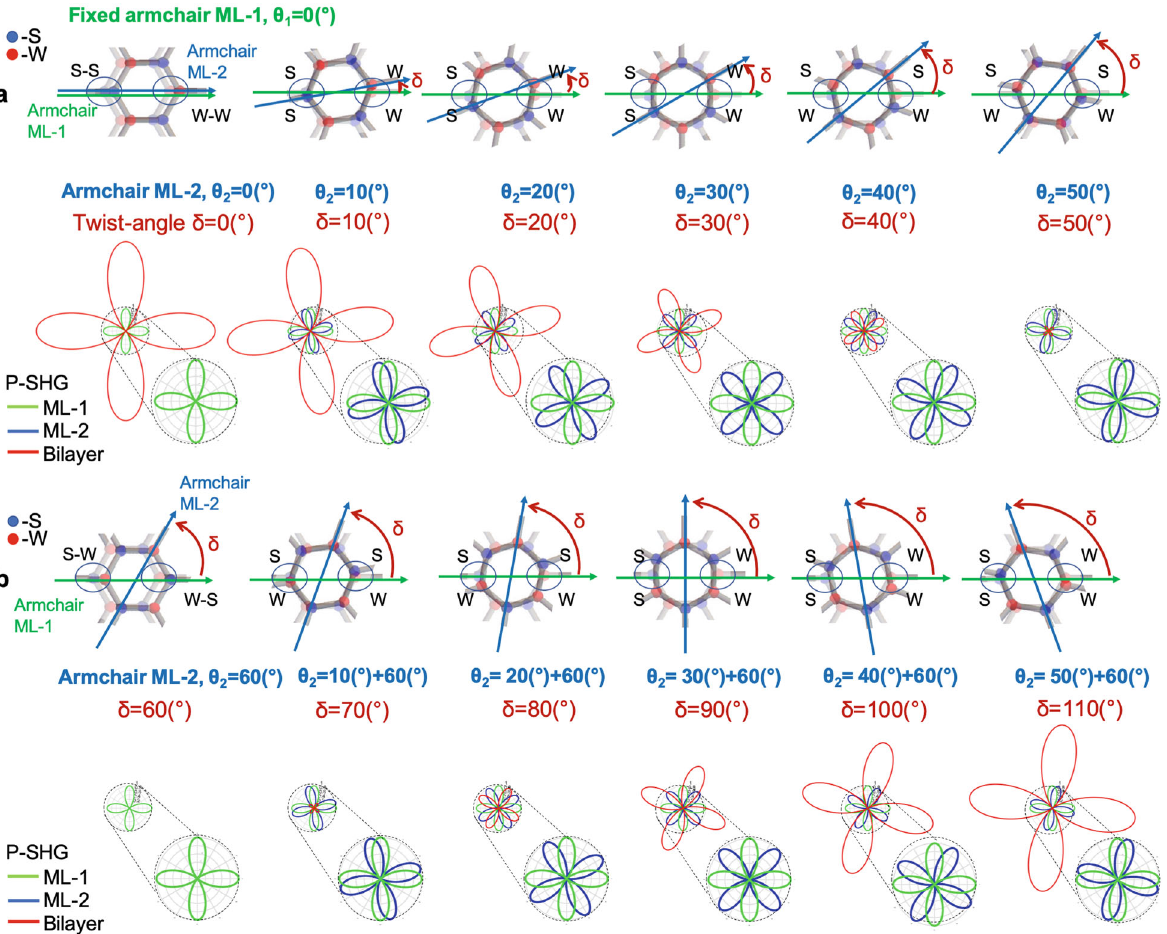
Fig. 2 P-SHG interference signatures in twisted WS 2 /WS 2 bilayers. a Schematic showing the dependence of P-SHG signal on the twist-angle for fi xed armchair direction ML-1, ( θ 1 = 0(°)) and varying armchair direction θ 2 of ML-2, θ 2 ∈ [0(°) – 50(°)], with step 10(°). Top view atom con fi guration hexagonal lattice of the bilayer and simulated polar diagrams of the interference P-SHG originated from the WS 2 /WS 2 bilayer (in red), as well as the simulated P-SHG signal modulation of each individual WS 2 ML (green for ML-1 and blue for ML-2). b P-SHG signal modulation for fi xed θ 1 = 0(°) and varying θ 2 ∈ [60(°) – 110(°)], with step 10(°). By comparing a with b, we notice that the same green and blue P-SHG polar diagrams can provide two different interference P-SHG red polar diagrams. Therefore, we are able to de fi ne unequivocally the armchair direction θ 2 that contributes to the SHG signal of the bilayer in the range of 0(°) ≤ θ 2 ≤